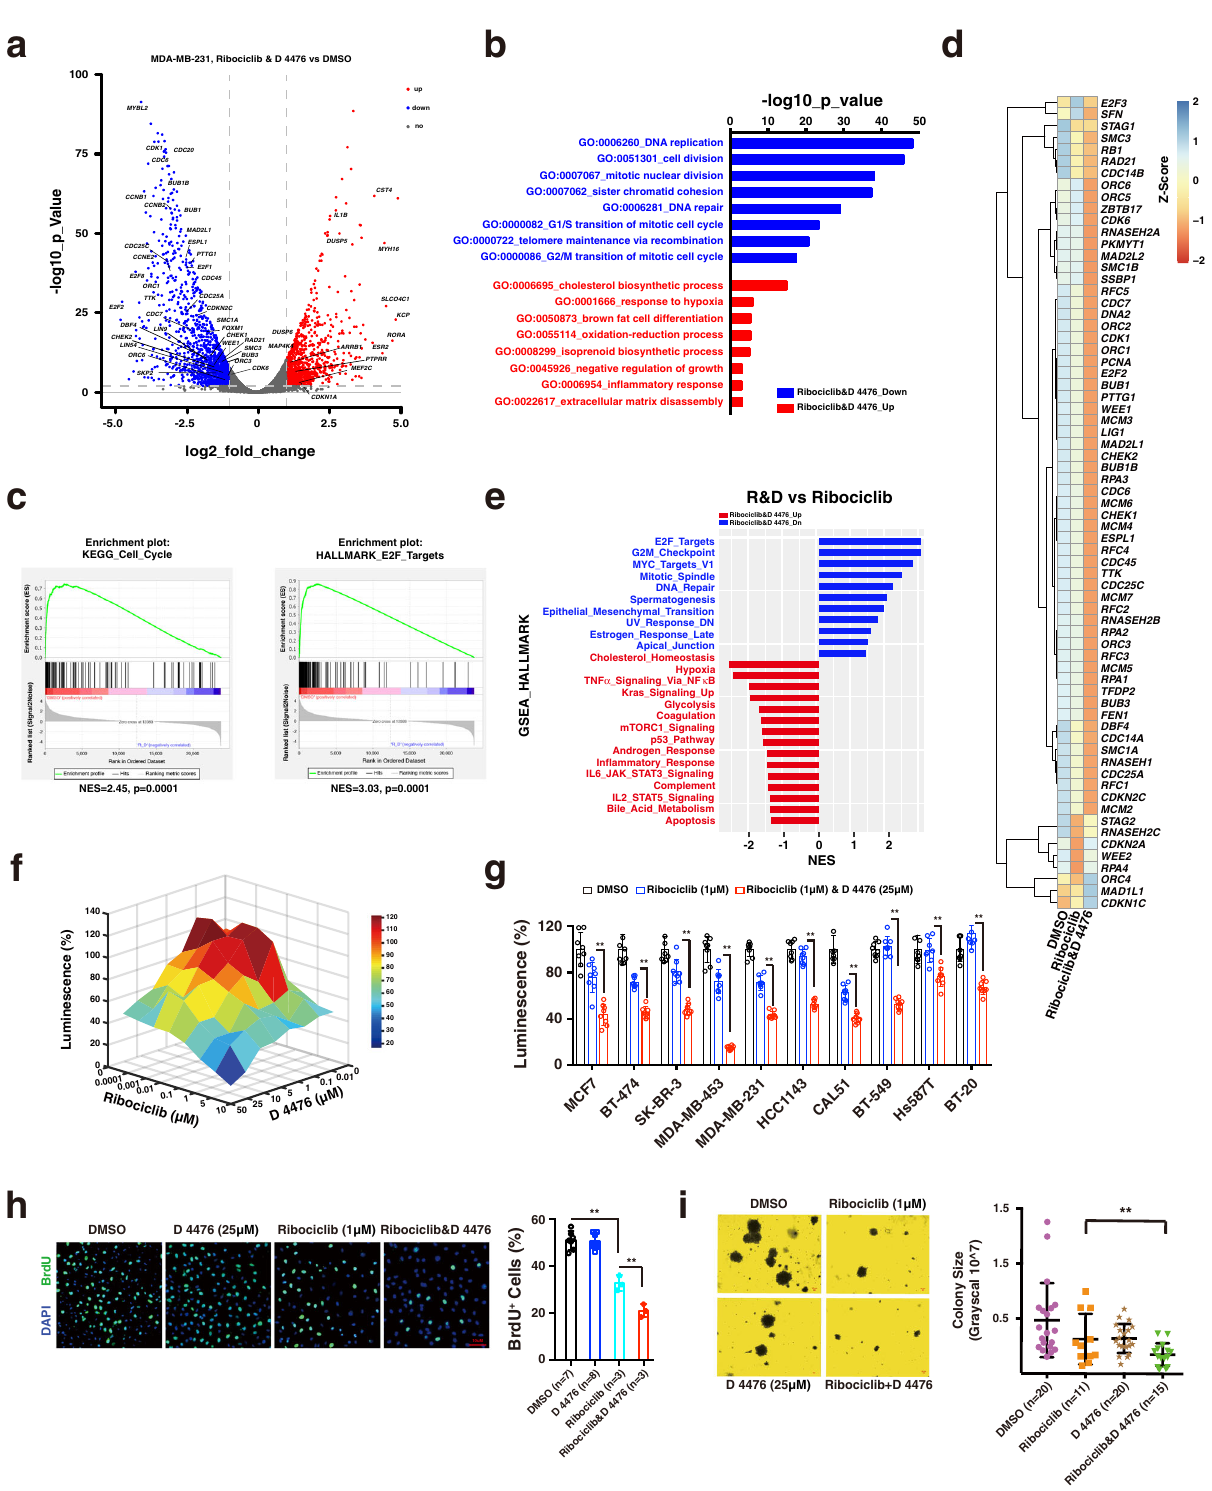
therapeutic ef fi cacy of CDK4/6i ribociclib in retarding